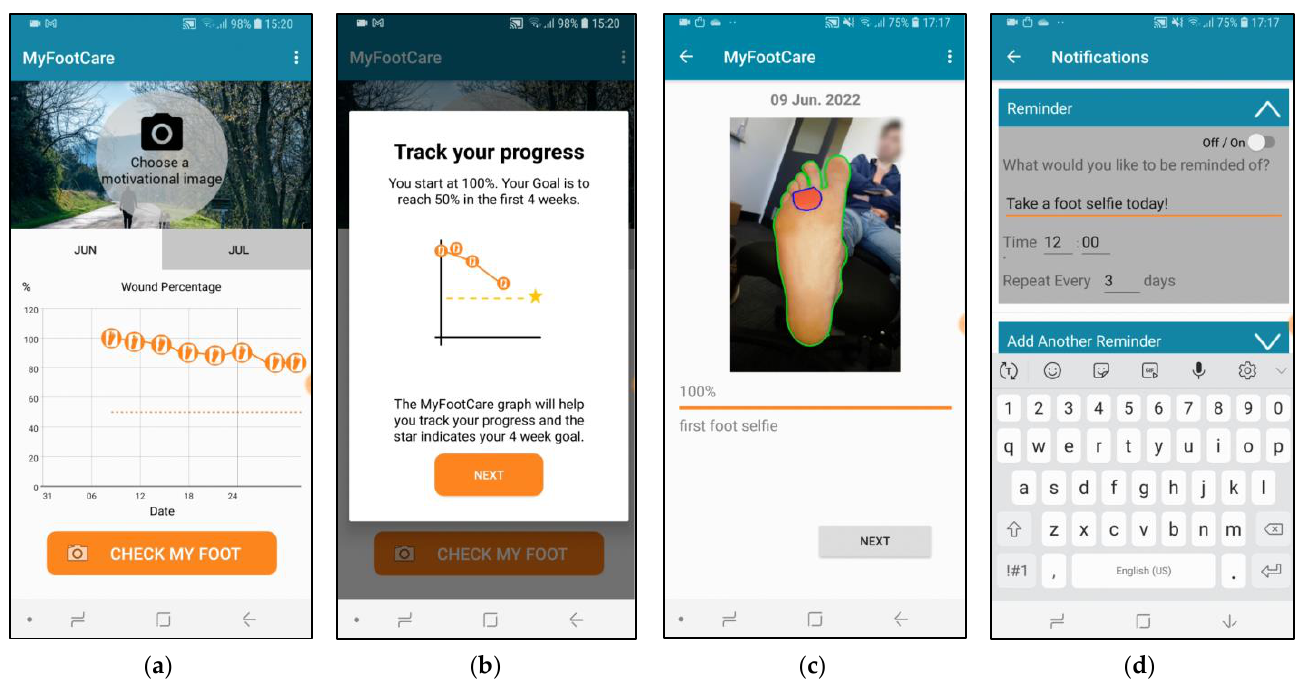
Figure 1. MyFootCare features. ( a ) A motivational image on the top of the home screen visualises a person’s goals (e.g., to go for a walk). A progress graph shows changes in DFU size over time. ( b ) A star on the graph visualises the goal to reach a 50% reduction within 4 weeks. ( c ) Patients can review all foot checks through a gallery. ( d ) Notifications to take foot selfies can be tailored under settings.